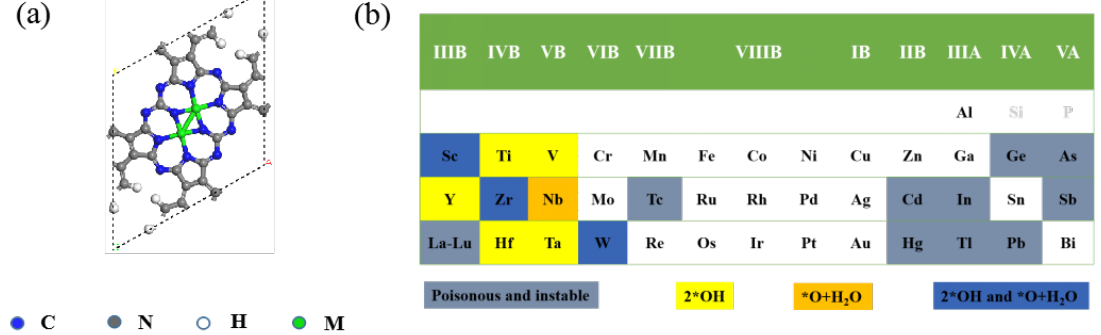
Figure 1. ( a ) Top view of M 2 -Pc sheet. ( b ) The metals examined in this work. The poisonous metals were indicated in gray; the metals assist H 2 O 2 decomposition into 2*OH or *O and H 2 O are highlighted in yellow and orange, respectively; the metals could decompose H 2 O 2 into either 2*OH or *O and H 2 O are represented in blue; metals in white cannot spontaneously decompose H 2 O 2 .